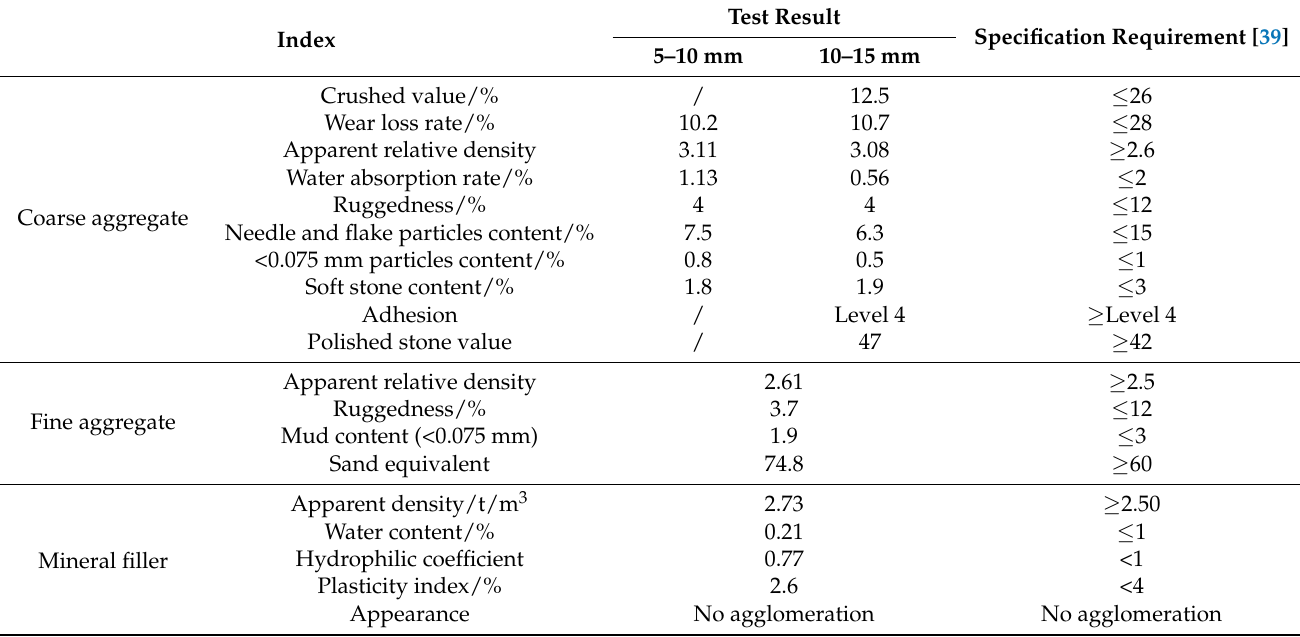
Table 4. Physical parameters of aggregates and mineral filler.